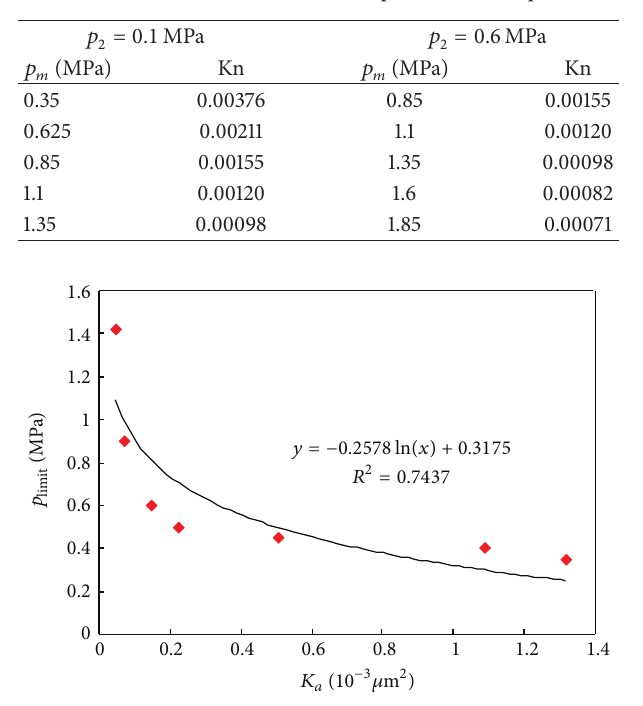
Figure 7: Relationships between 𝐾 𝑎 and 𝑝